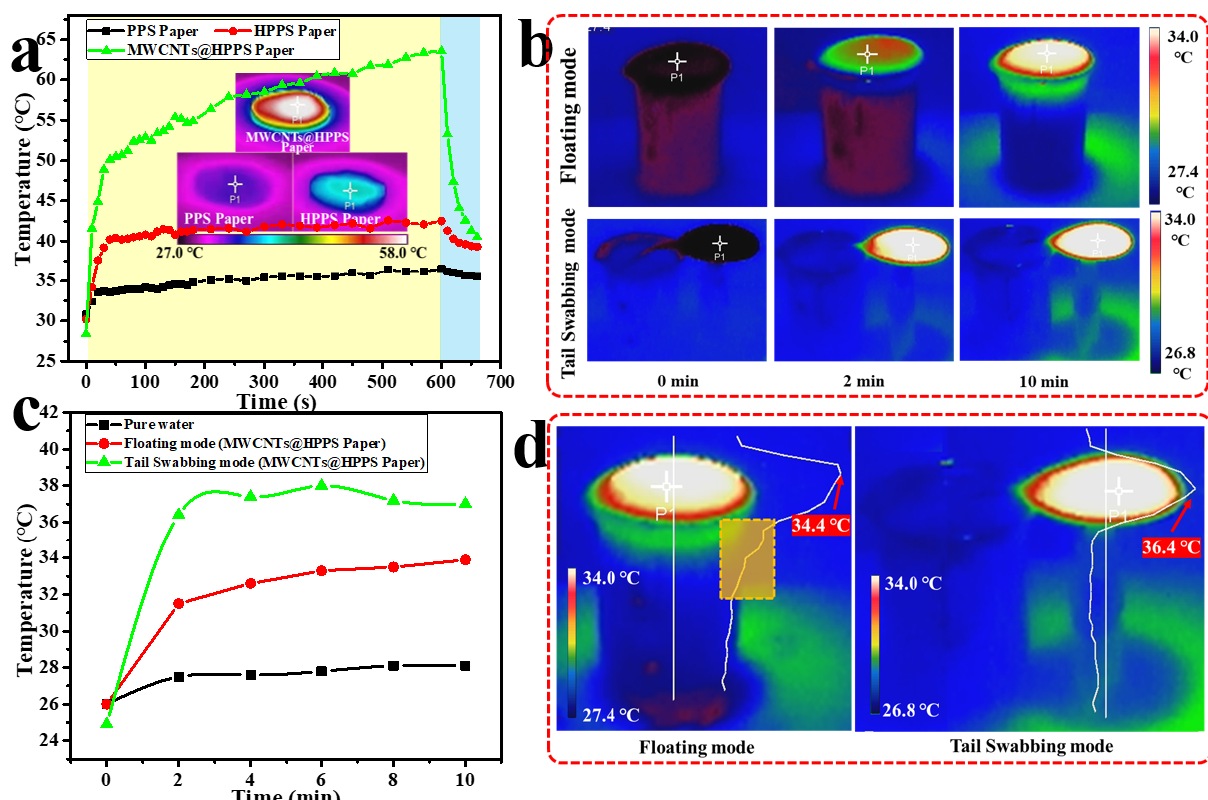
Figure 7. ( a ) Temperature elevation and IR images of the surface of PPS, HPPS and MWCNTs@HPPS papers under 1 sun illumination for 10 min; IR images ( b ) and temperature elevation ( c ) of experimental devices under 1 sun; ( d ) IR images and temperature curve along the axial direction of experimental modes under 1 sun after 10 min.